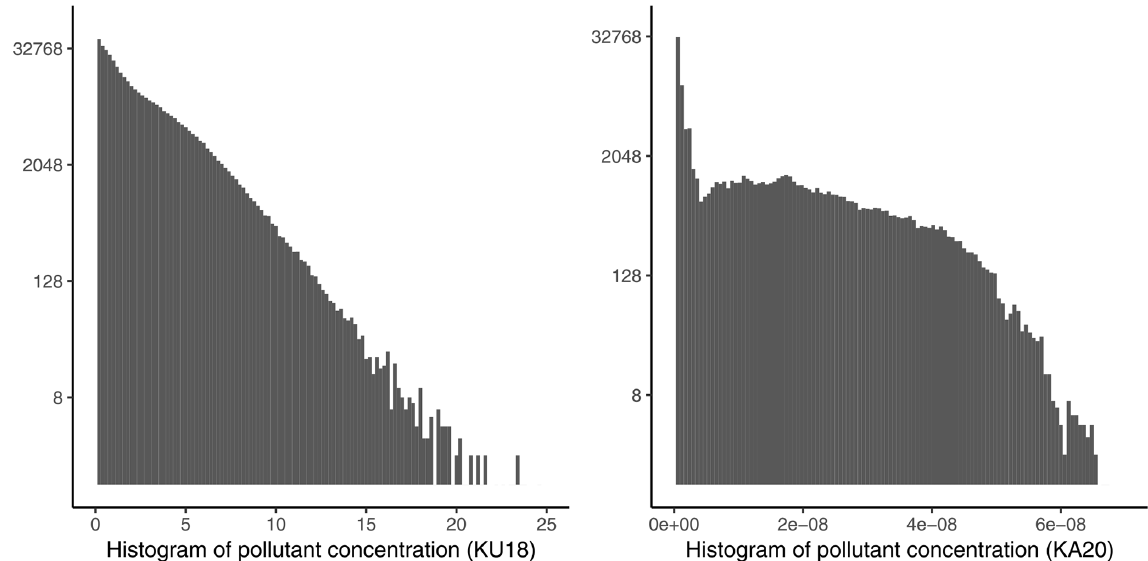
Figure 2. Histograms of air pollutant concentrations in KU18 and KA20. Note the log scale of the counts on the y axis and the differing scales on the x axis. KA20 has units kgm − 3